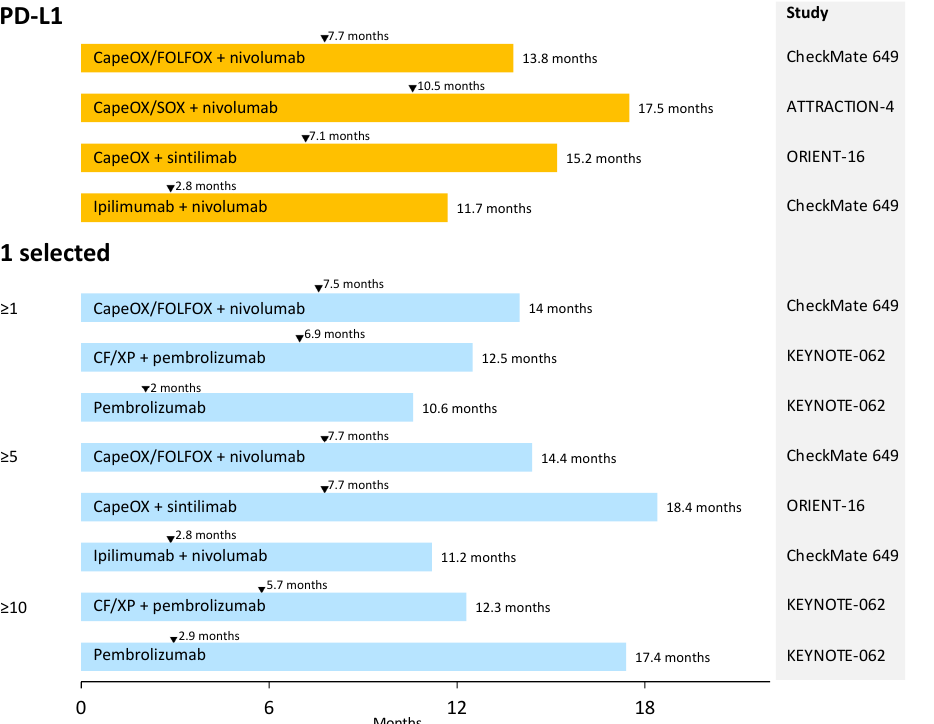
Figure 2. Upfront immunotherapy of patients with advanced gastric cancer. The left side shows PD-L1 status. The middle bar indicates the median OS, and the black triangle indicates the median PFS. On the right side, the clinical trials are listed. ( A ) Immune checkpoint inhibitors plus cytotoxic drugs or dual blockade with ipilimumab and nivolumab, irrespective of PD-L1 expression. ( B ) Immune checkpoint inhibitors plus cytotoxic drugs, single-agent immune checkpoint inhibitors, or dual blockade with ipilimumab and nivolumab on the basis of PD-L1 CPS. Abbreviation: PD-L1, programmed cell death protein 1; CapeOX, capecitabine + oxaliplatin; XP, capecitabine + cisplatin; FOLFOX, fluoropyrimidine + leucovorin + oxaliplatin; SOX, S-1 + oxaliplatin; PFS, progression-free survival; CF, cisplatin + fluoropyrimidine.